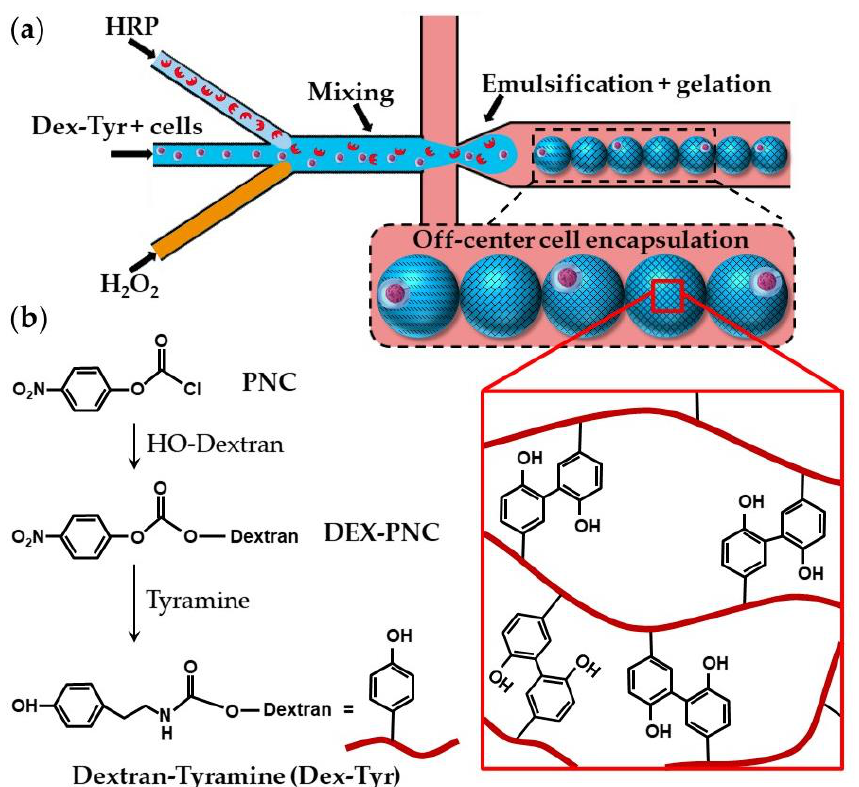
Figure 19. ( a ) Encapsulation of single cells using dextran-tyramine (Dex-Tyr) microgels by in situ mixing cells, polymer, and crosslinkers just before droplet pinch-off. Cells are trapped in their off- center positions because of the inertial effects and fast crosslinking reaction [75]. ( b ) Synthesis of Dex-Tyr conjugates by activating hydroxyl groups of dextran with p-nitrophenyl chloroformate (PNC). Dex-Tyr crosslinks by forming tyramine-tyramine bonds in the presence of HRP and H 2 O 2 [74].